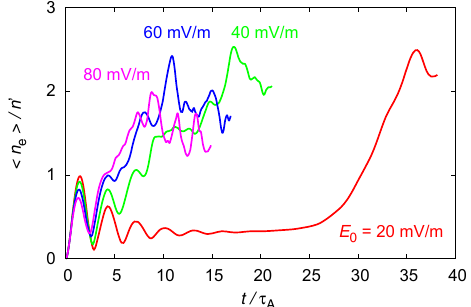
Figure 6. Time variation in root-mean-square electron density (cid:104) n e (cid:105) at the ionosphere for E 0 = 20, 40, 60, and 80mVm − 1 .